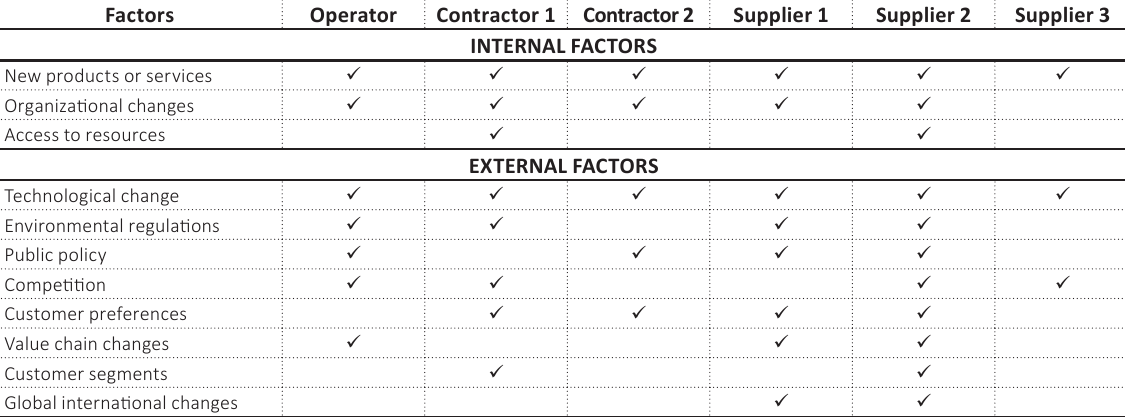
Table 2. Factors that have contributed to innovations in business models during the last years